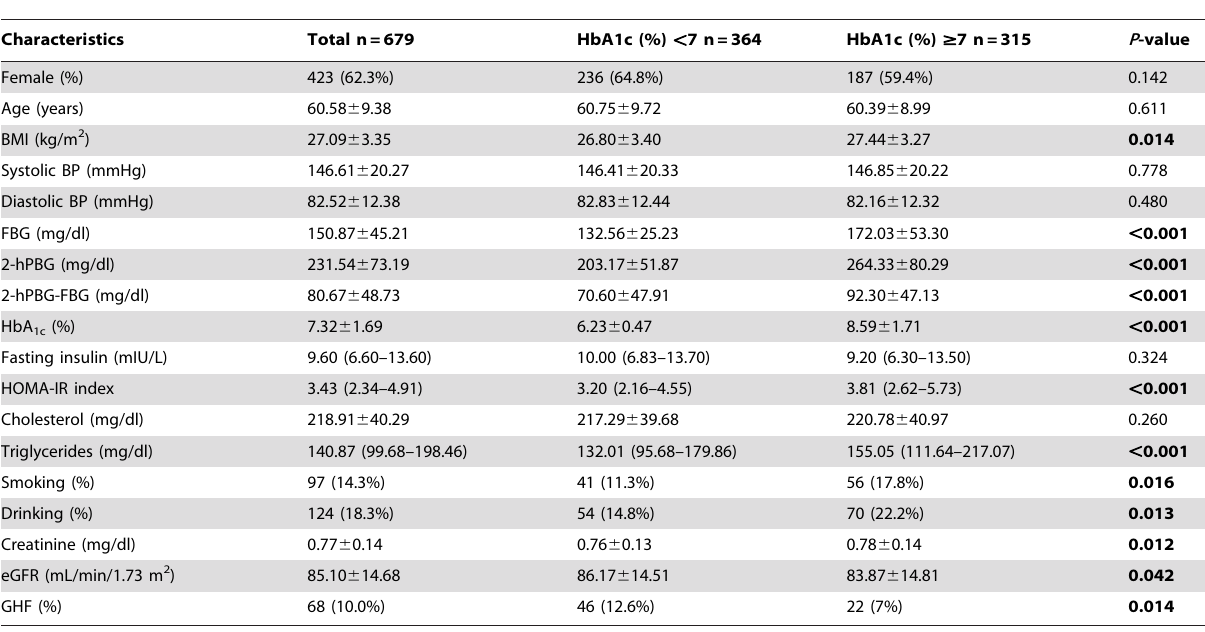
Table 1. Characteristics of study participants grouped by HbA1c category.